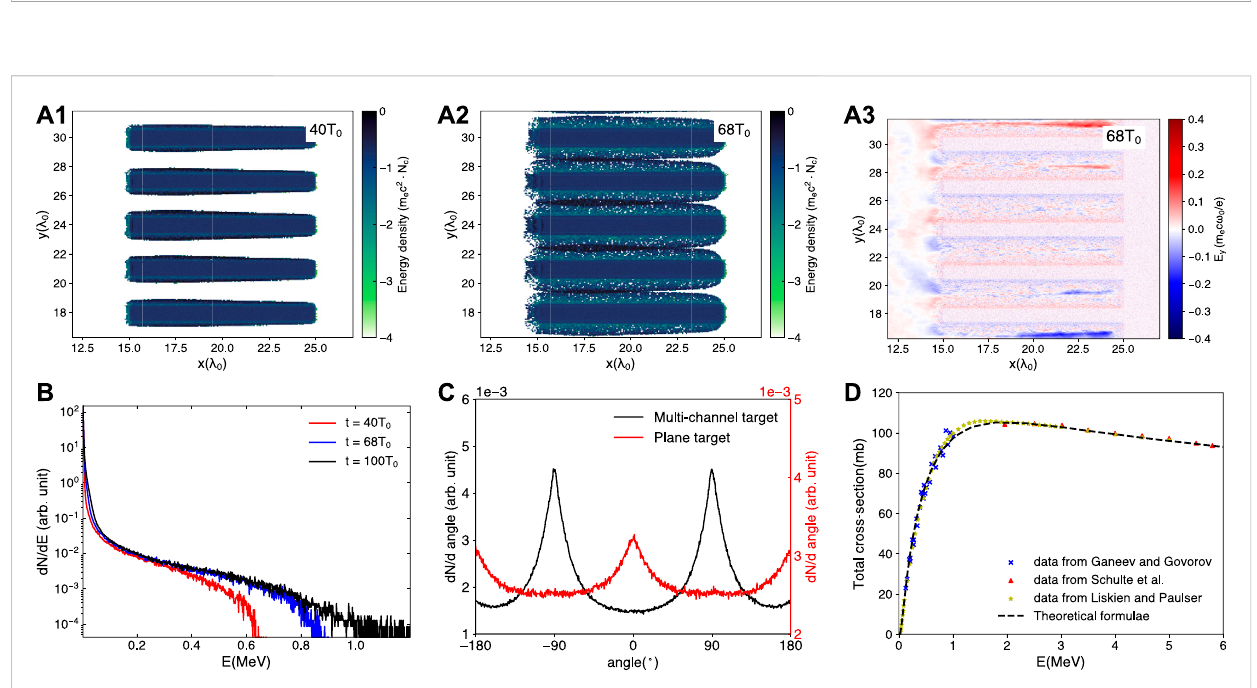
FIGURE 5 (A1,A2) The energy spectrum ofwires deuterium ions at40T 0 and 80T 0 . (A3) Spatial distribution ofthetransverse sheath fi eld E sy at 80T 0 . (B) Energy spectrumofwiresdeuteronsatdifferenttimes. (C) Angularspectrumofwiresdeuteronsfordifferenttargetsat100T 0 ,wheretheblacklinerepresentsthe MCT and the red line represents the PT. (D) The total cross-section of D-D reaction. The experimental data came from [42 – 44] and theoretical calculation [45] is the method used in Smilei